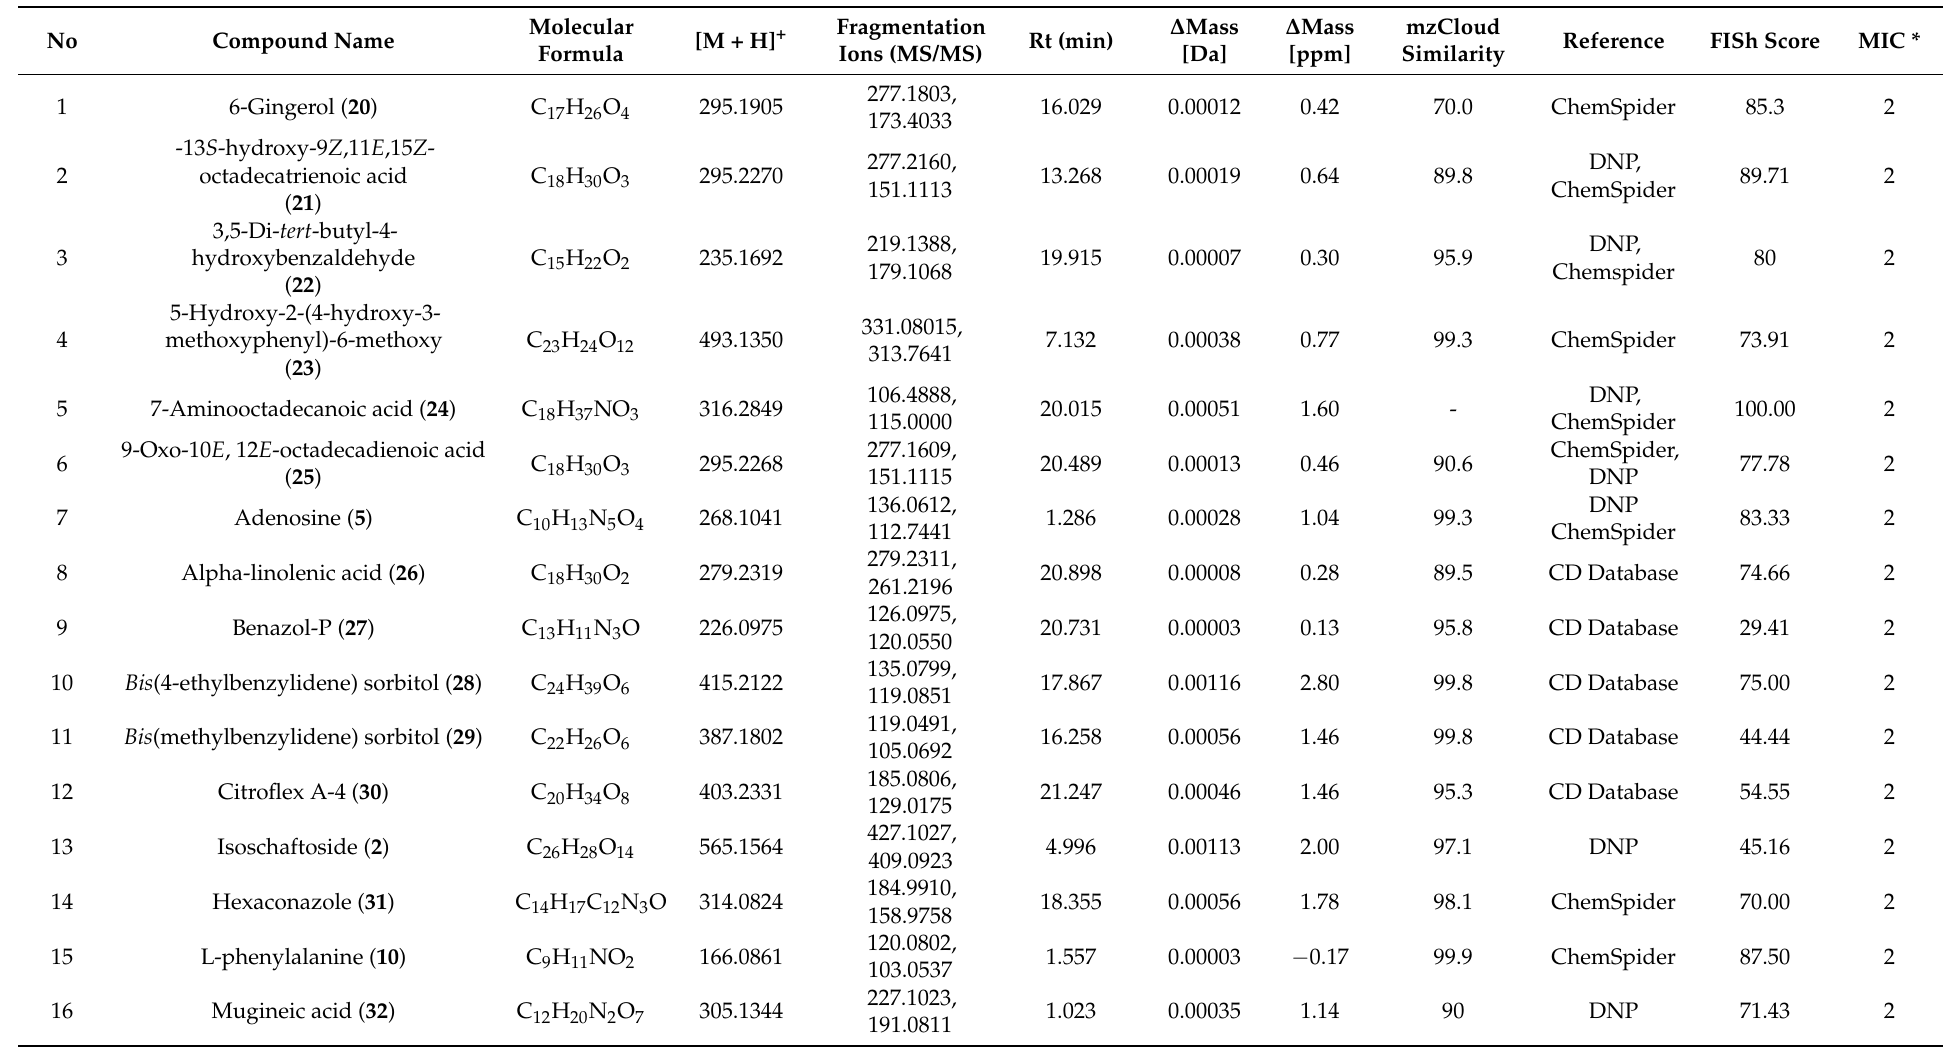
Table 3. Phytochemicals hits from the Compound Discoverer